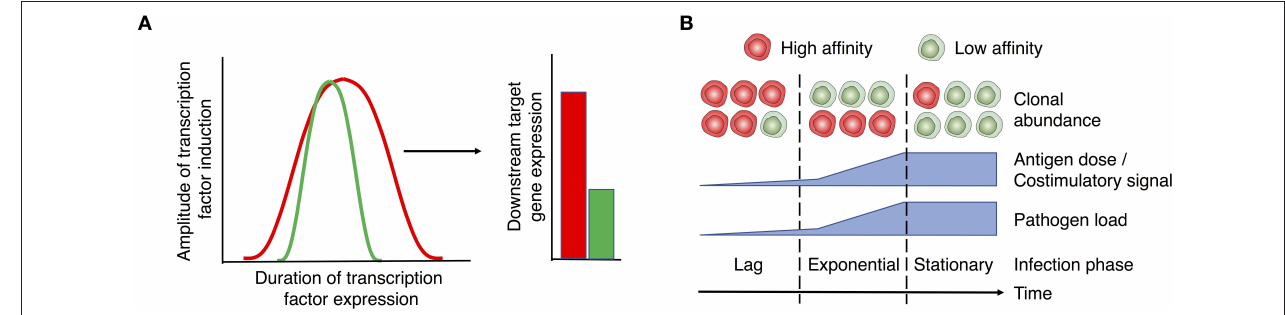
FIGURE 2 | Proposed role of TCR signal strength in T cell function and expansion. (A) TCR signals initiate the “all or nothing” digital induction of transcription components, such as ERK, NF- κ B, and NFAT. The amplitude of their expression is independent of the strength of input signals. Instead, TCR signal strength determines the duration of transcription factor activity (left panel), translating the digital expression pattern of transcription factors into the analog expression of some downstream targets like CD69, CD25, Myc, and IRF4 (right panel). Red and green lines/bars denote strong and weak TCR signals and the associated responses. (B) T cell activation and expansion are regulated by the interplay between T cell-intrinsic factors (e.g., TCR affinity) and extrinsic factors (e.g., the levels of antigen and costimulation associated with different disease stages). In the case of a persistent infection, the relative abundance of clones with high vs. low affinity TCRs may vary depending on the stage of infection. Early stages of infection, when low levels of antigen/costimulation are present, favor the expansion of clones with high affinity TCRs. As pathogen levels rise, lower affinity clones are able to undergo activation and equivalent expansion. As a potential strategy to prevent immunopathology during persistent stages of infection, clones with high affinity TCRs may be removed or silenced from the effector T cell pool. Therefore, low affinity clones may become the major population of effector T cells during chronic infection. Red and green cells denote T cells with high and low affinity TCRs,